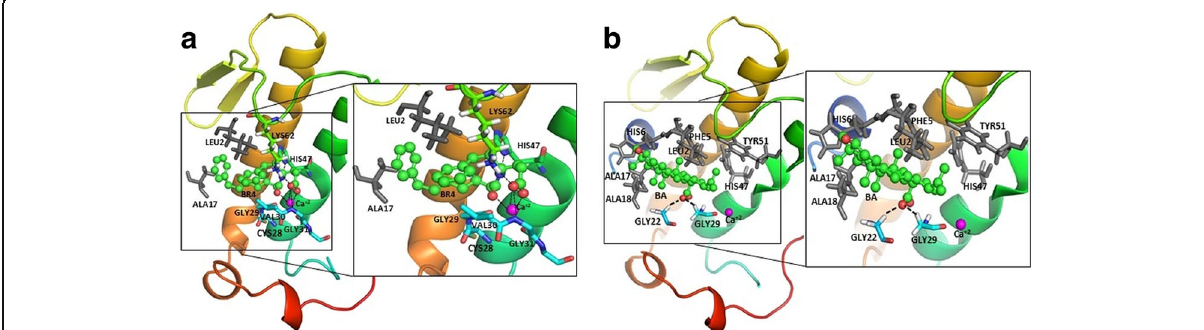
Fig. 2 Interaction of ( a ). BR4 (green) and ( b ). BA (green) with PLA2 visualized in pymol. The calcium ion (Ca +2 ) is presented as magenta color sphere. Black dash indicates H bonding. Residues involve in hydrophobic interactions are shown in gray color